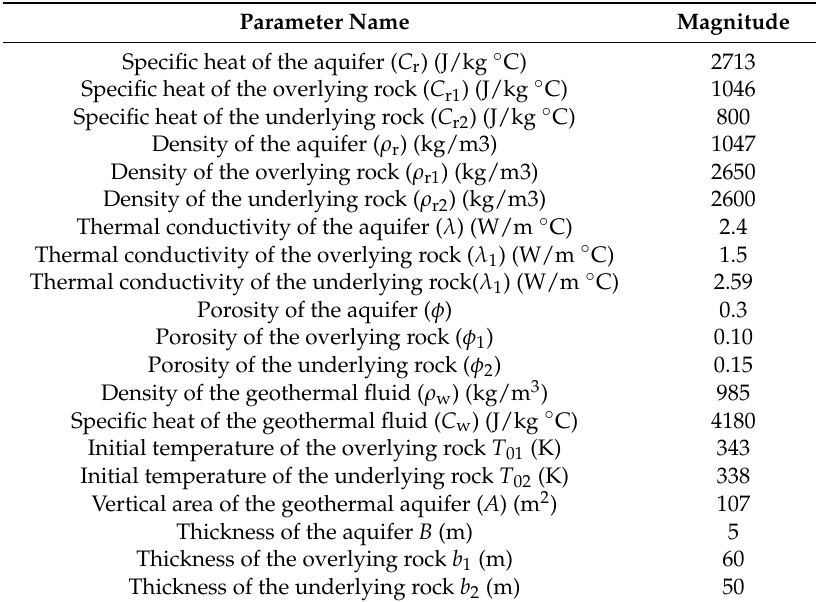
Table 1. Parameters of the rock and fluid